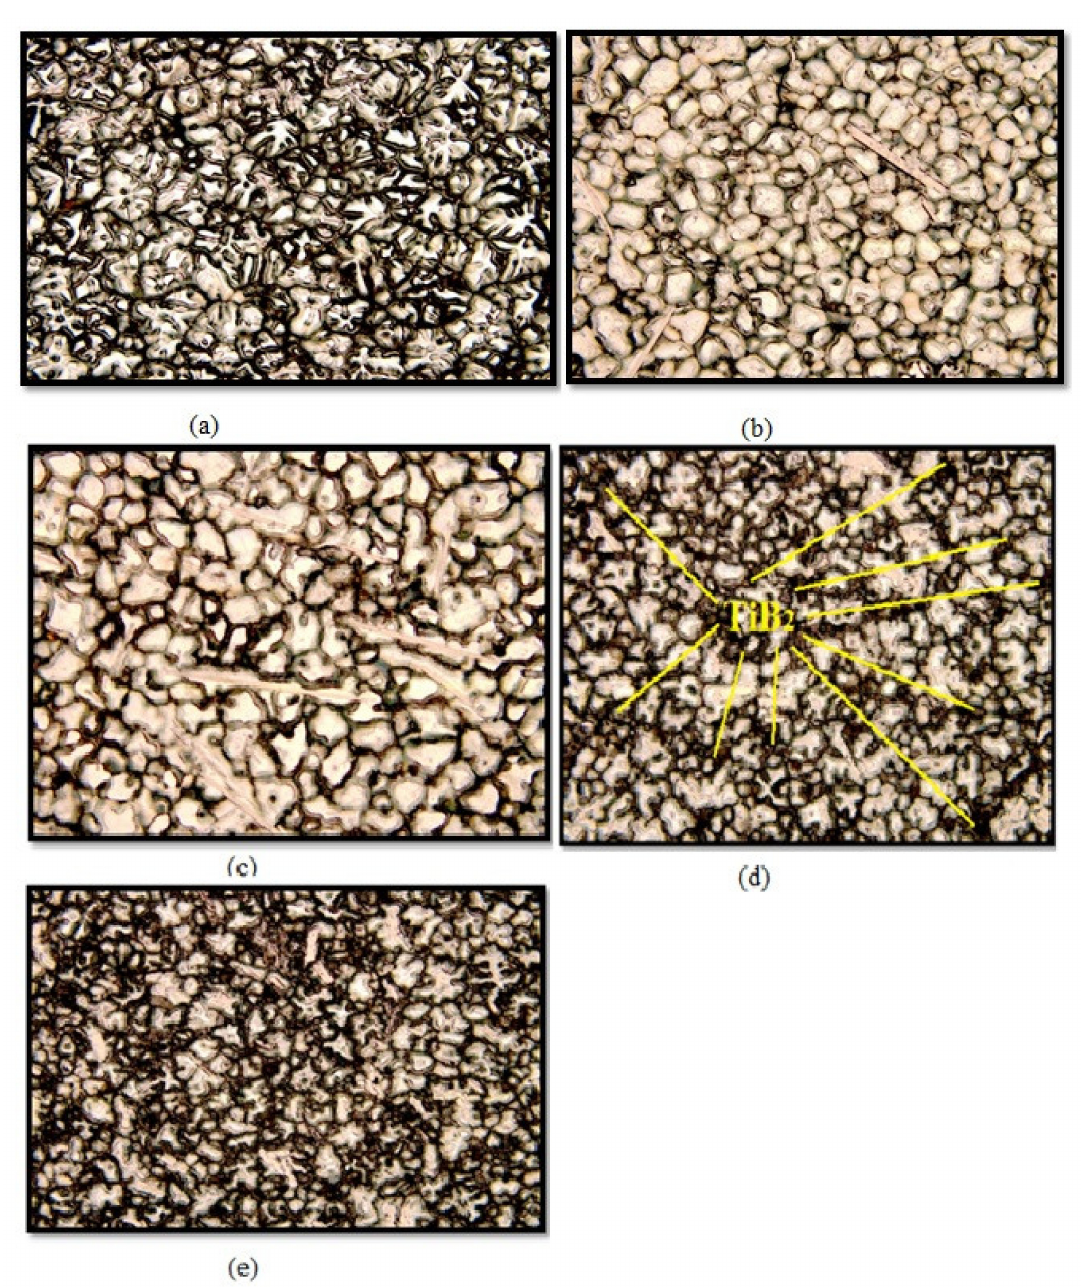
Figure 4. Optical microscopic image of AA7075/TiB 2 composite ( a ) 0 wt.% TiB 2 , ( b ) 3 wt.% TiB 2 , ( c ) 6 wt.% TiB 2 , ( d ) 9 wt.% TiB 2 and ( e ) 12 wt.% TiB 2